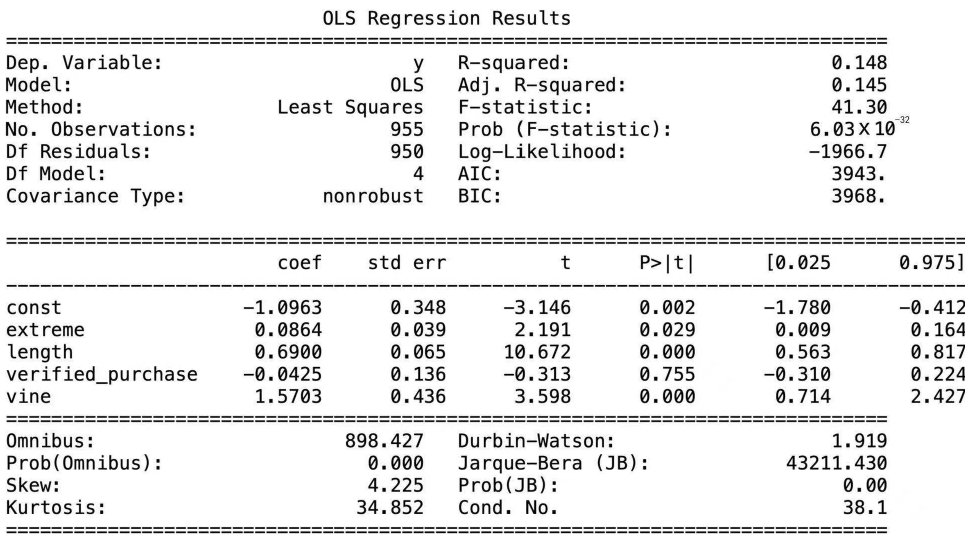
Figure 1. The regression result of the comment usefulness model.